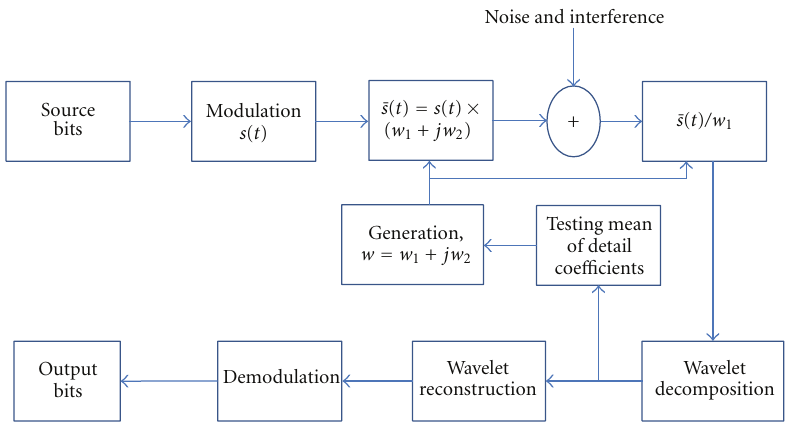
Figure 9: Wavelet denoising in communication signal processing.